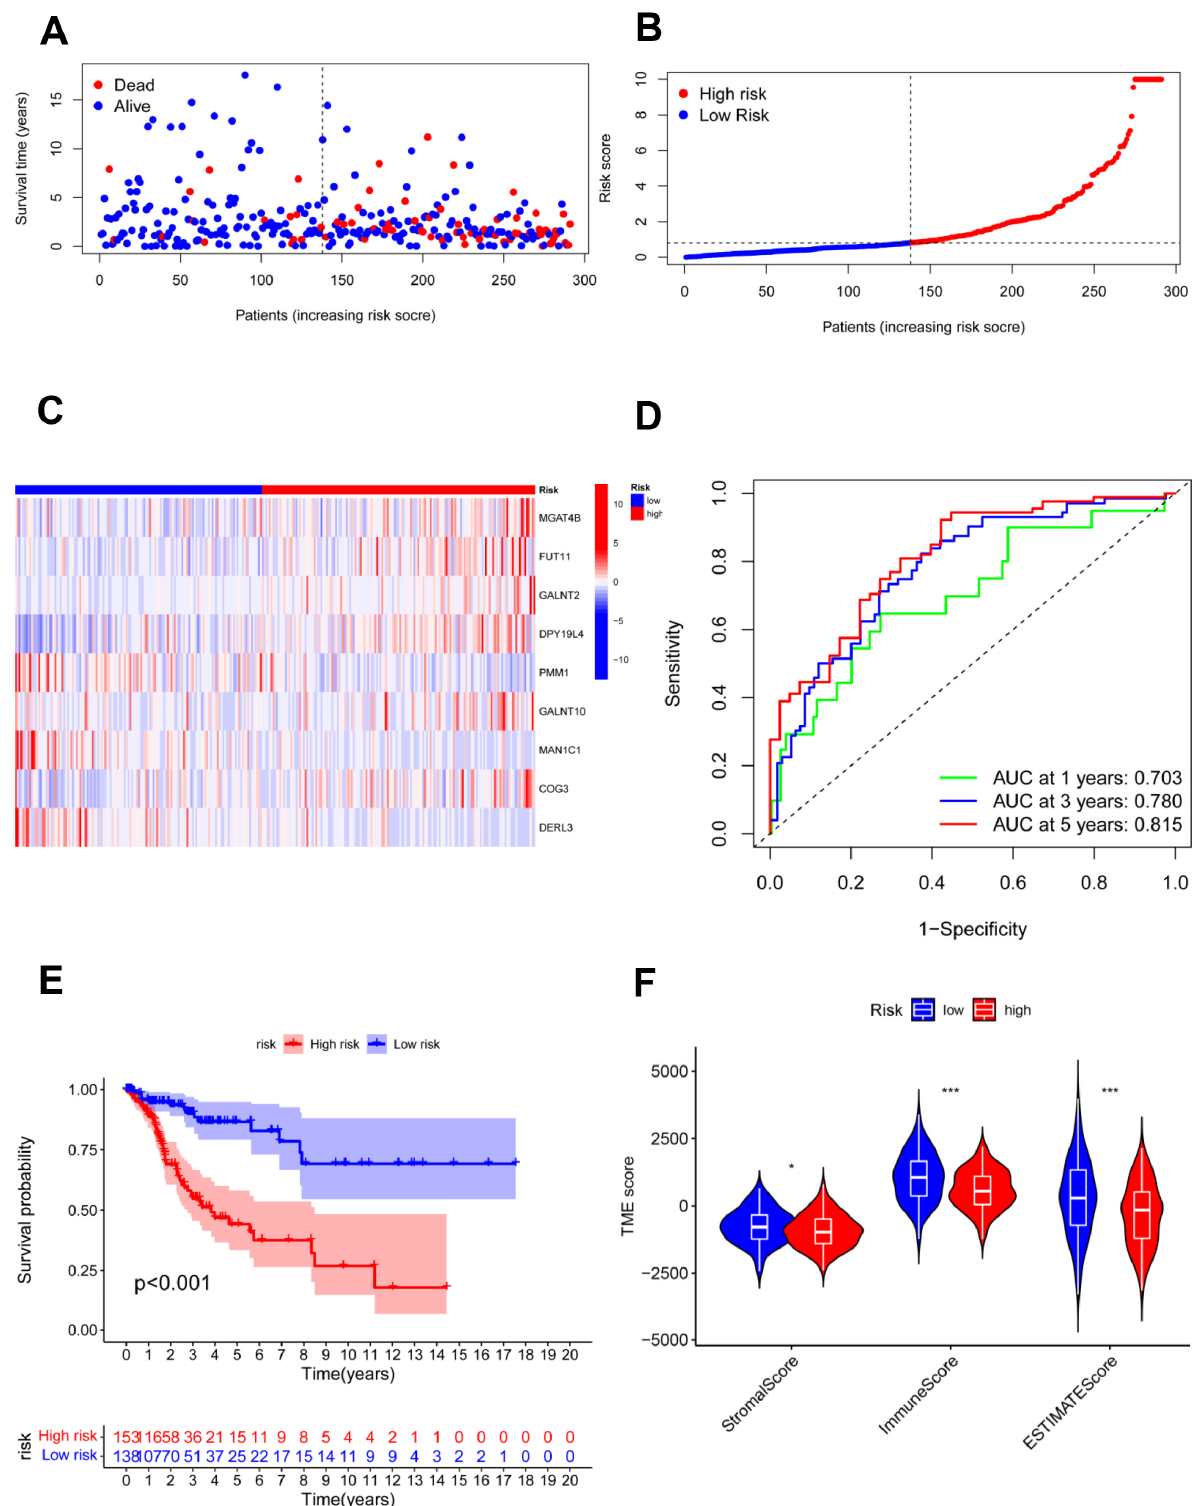
Figure 6. Validation of the risk model in the total cohort. ( A – B ) Assessments of the survival status and risk scores in the two groups; ( C ) the risk gene expression in the total cohort; ( D ) ROC curve in the total cohort; ( E ) survival curves of the CC patients in the two groups; ( F ) stromal, immune, and ESTIMATE scores of the two groups. * p < 0.05; *** p < 0.001. The risk model and clinical data including the age, FIGO stage, risk, and histopatho- logical grade of CC patients were incorporated into a nomogram to more accurately pre- dict the prognosis of CC patients (Figure 7A). The risk score and clinical risk factors were endowed with a certain score according to their impact on the prognosis in CC. The C-